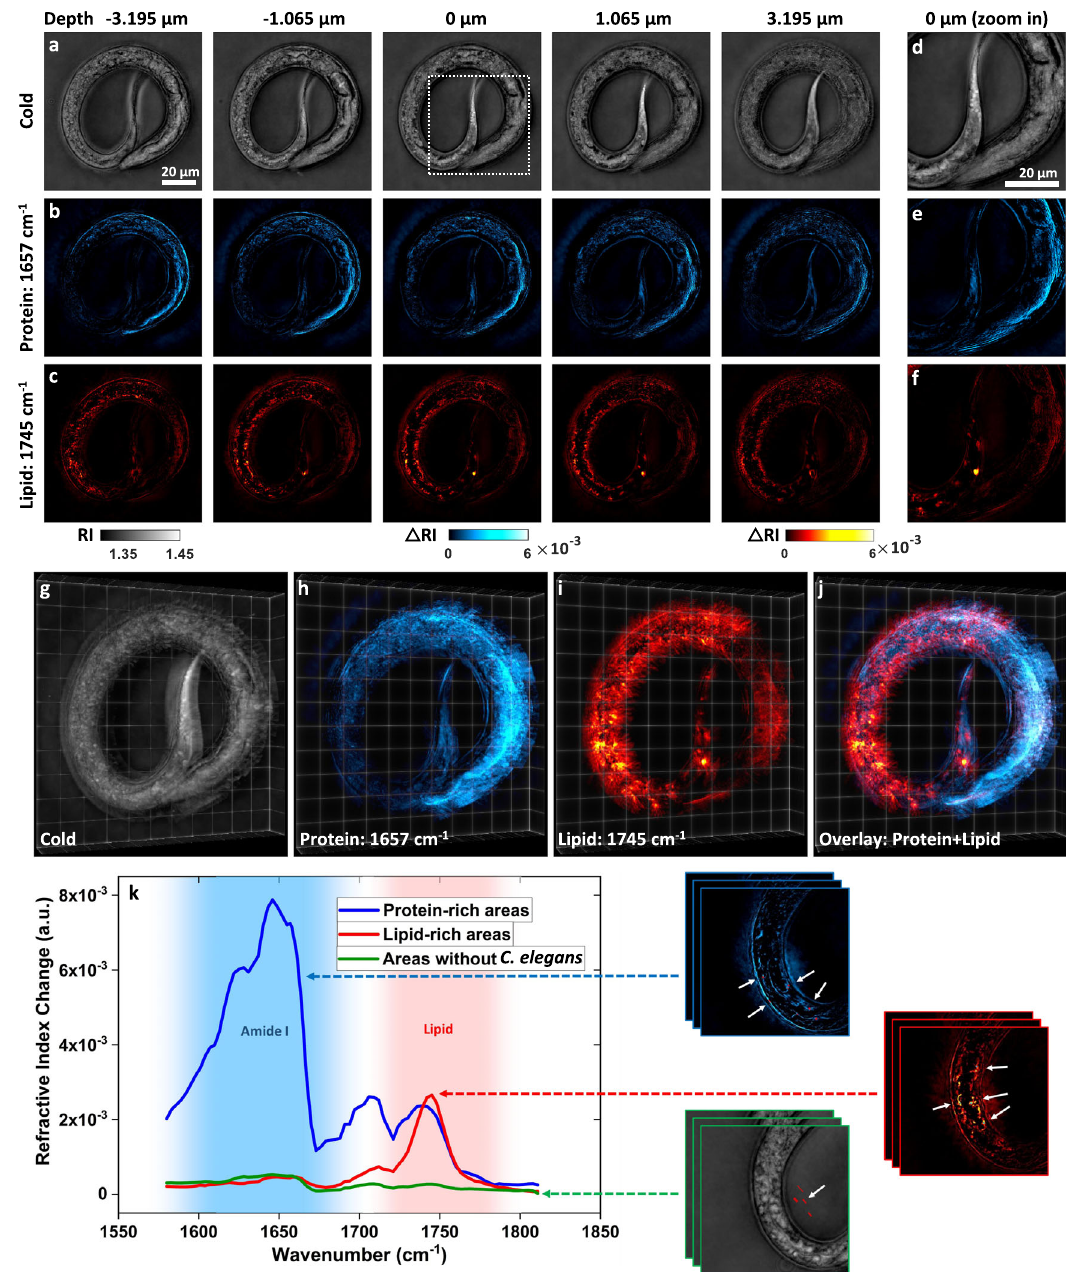
Fig. 5 | BS-IDT imaging and fi ngerprint spectroscopy on C. elegans . a – j Sample: fi xed C.elegans (daf-2(e1370)mutantstrain)immersedinD images in eachcolumn arefrom the same depth. Images ineachrow are under the samemid-IRlaserilluminationconditions.Thescalebarin “ a ” isapplicableto “ a – c ” . Thescalebarin “ d ” isapplicable to “ d – f ” . a , d Depth-resolved coldimaging